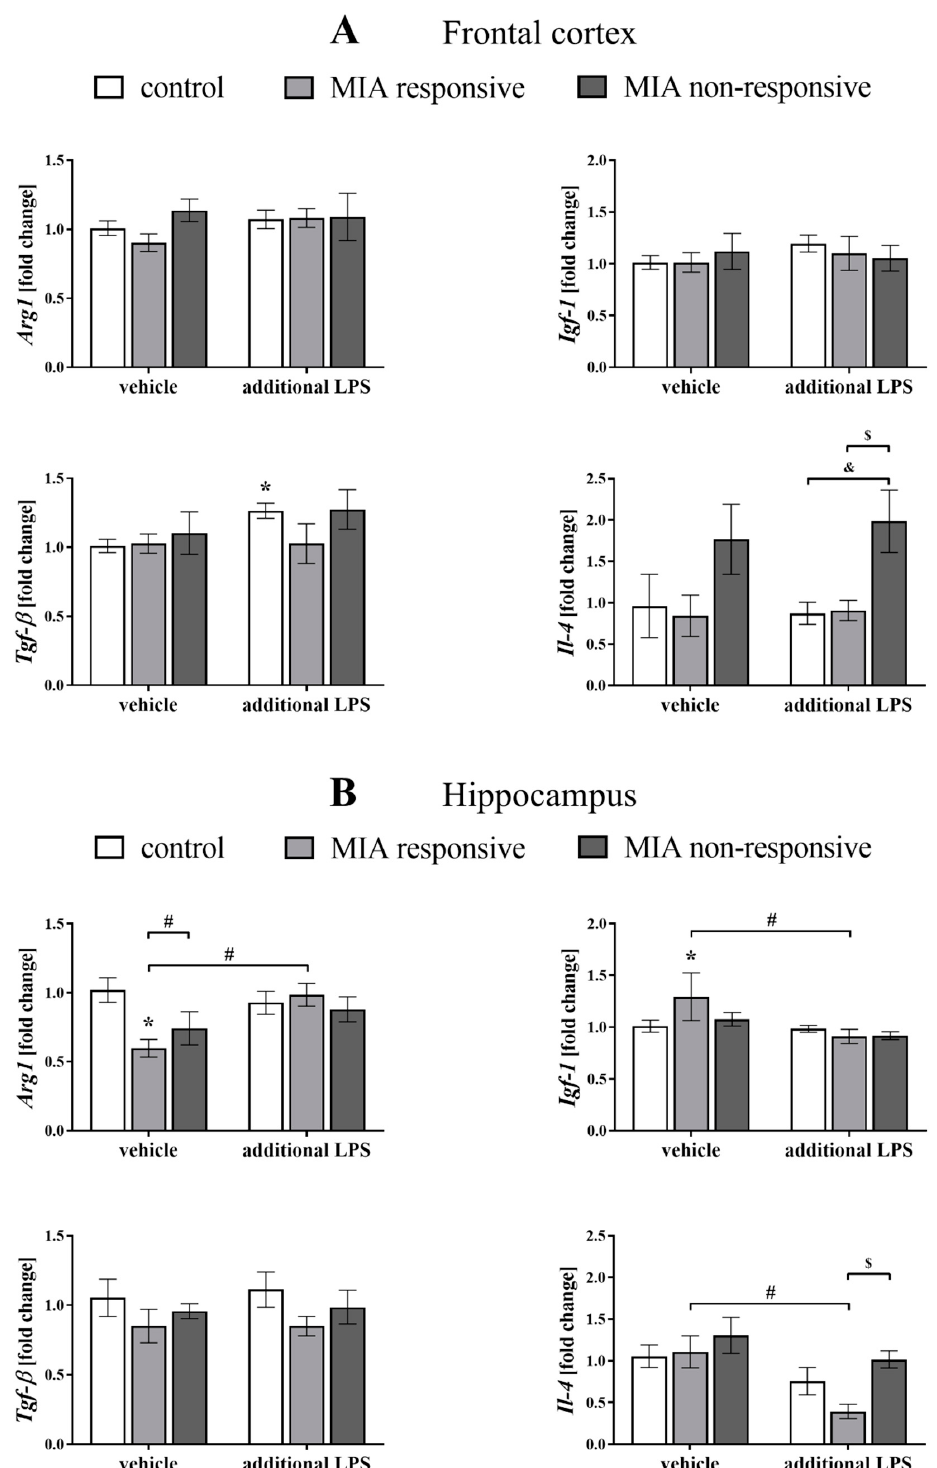
Figure 10. The effect of MIA and the additional acute challenge with LPS on the gene expression of the anti-inflammatory microglial markers: Arg1 , Igf-1 , Tgf- β and Il-4 in the frontal cortices ( A ) and hippocampi ( B ) of male Sprague-Dawley o ff spring at PND120. The mRNA levels were measured using qRT-PCR with n = up to 10 in each group. The results are presented as the average fold change ± SEM. * p < 0.05 vs. control + vehicle, # p < 0.05 vs. MIA responsive + vehicle, $ p < 0.05 vs. MIA responsive + LPS, & p < 0.05 vs. control +